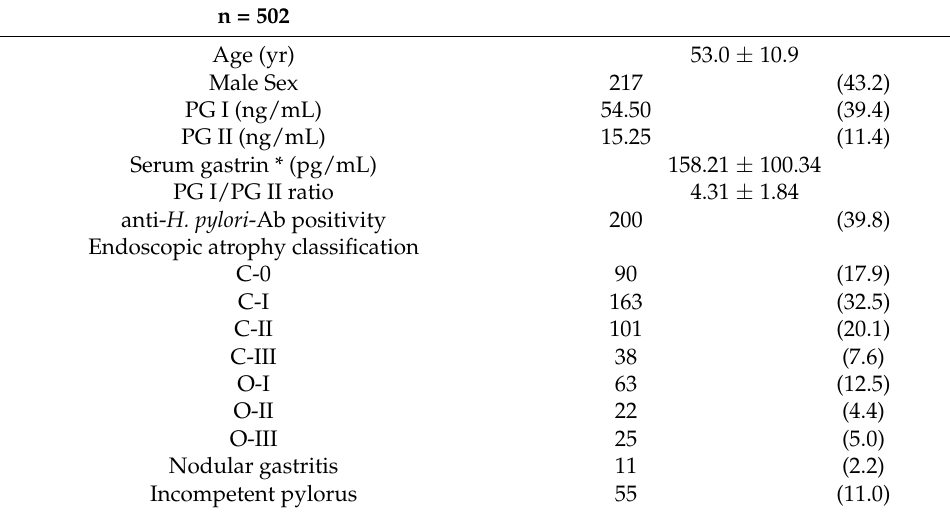
Table 1. Basic characteristics of the participants.